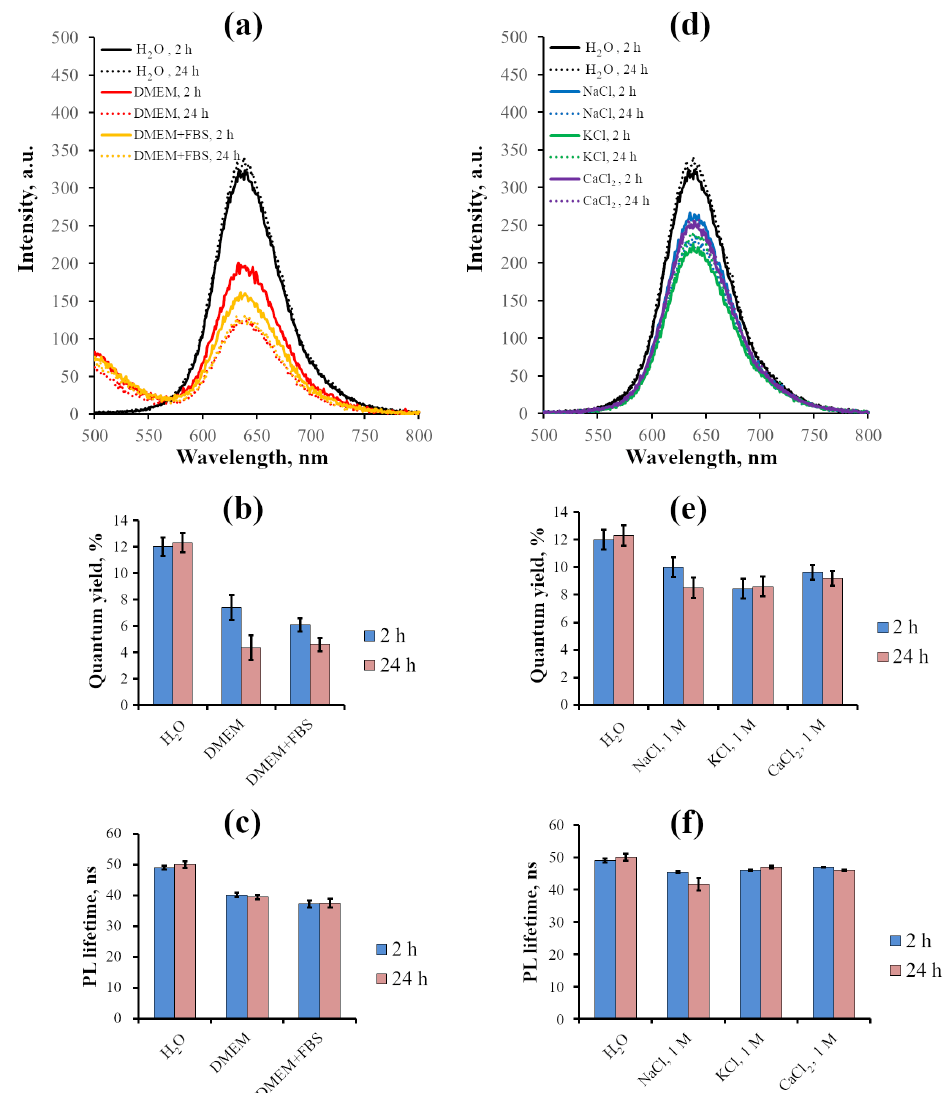
Figure 2. Photophysical characteristics of InP-QDs (80 nM) in various solutions (H 2 O, Na + , K + , and Ca 2 + solutions and DMEM) after incubation for 2 and 24 h. ( a ): Luminescence spectra of InP-QDs in DMEM; ( b ): Quantum yields of InP-QD luminescence in DMEM, %; ( c ): Lifetimes of InP-QDs luminescence in DMEM, ns. ( d ): Luminescence spectra of InP-QDs in aqueous salt solutions; ( e ): Quantum yields of InP-QD luminescence in aqueous salt solutions, %; ( f ): Lifetimes of InP-QD luminescence in aqueous salt solutions, ns. Data ( b , c , e , f ) represent the mean ± standard error of the mean from at least three independent